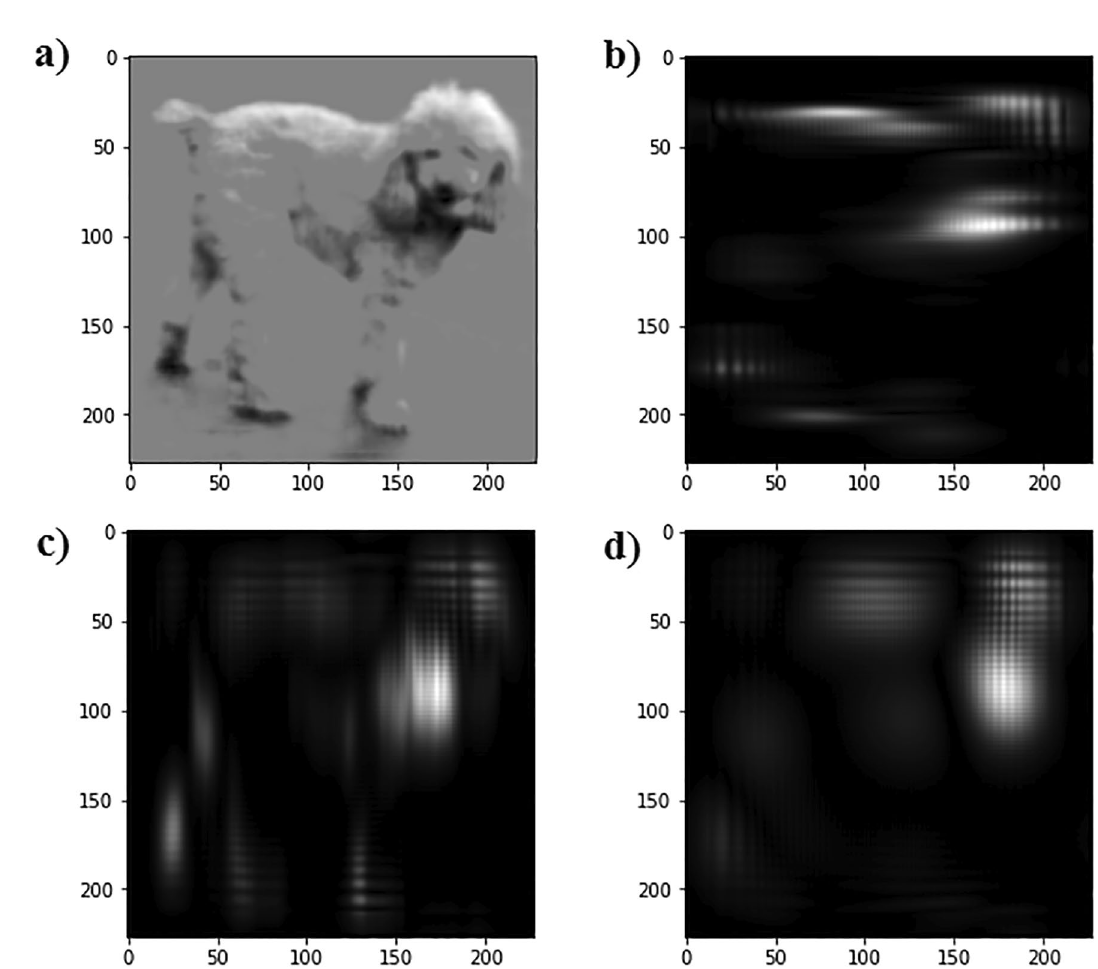
Figure 6. ( a ) input image, ( b ) correlation result of input image with vertical motion filter with w = 227 and σ = 2, ( c ) correlation result of input image with horizontal motion filter with w = 227 and σ = 2, and ( d ) correlation result of input image with diagonal motion filter with w = 227 and σ =